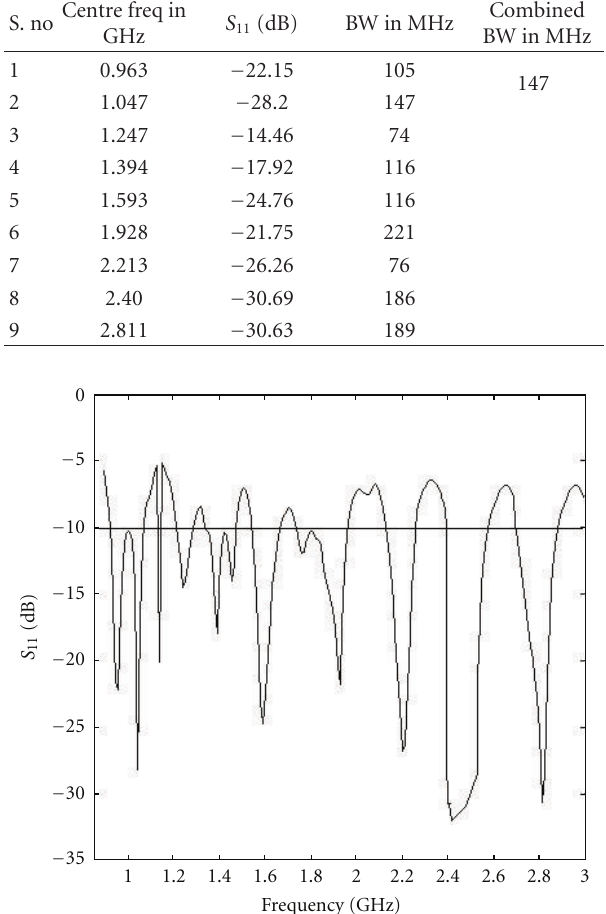
Table 2: Measured S 11 for an self-a ffi ne fractal antenna. Centre freq in S. no GHz